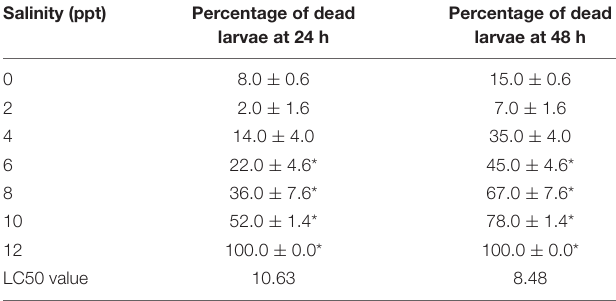
All embryos died within 12 h *Significance level (p < 0.05). TABLE 3 | Effects of salinity on larval mortality of striped catfish ( n = 150 larvae). Salinity